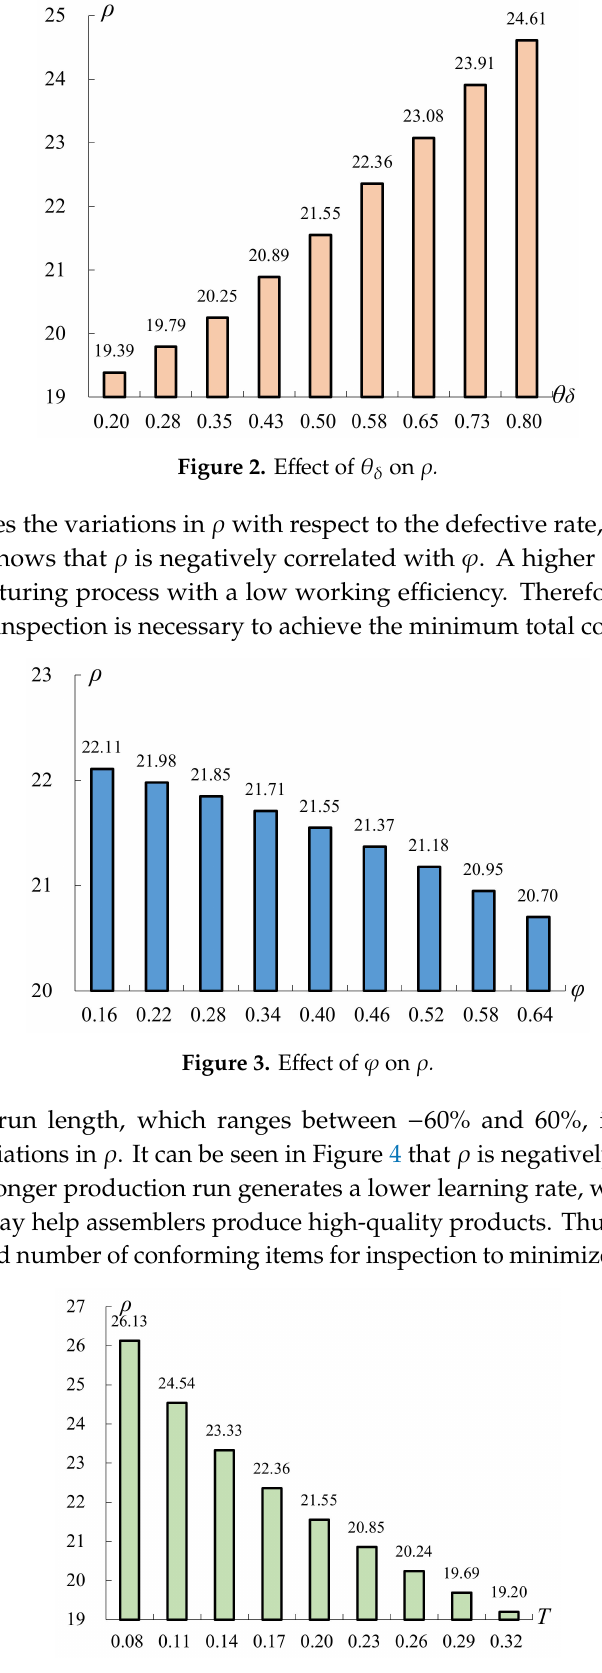
Figure 4. E ff ect of T on ρ